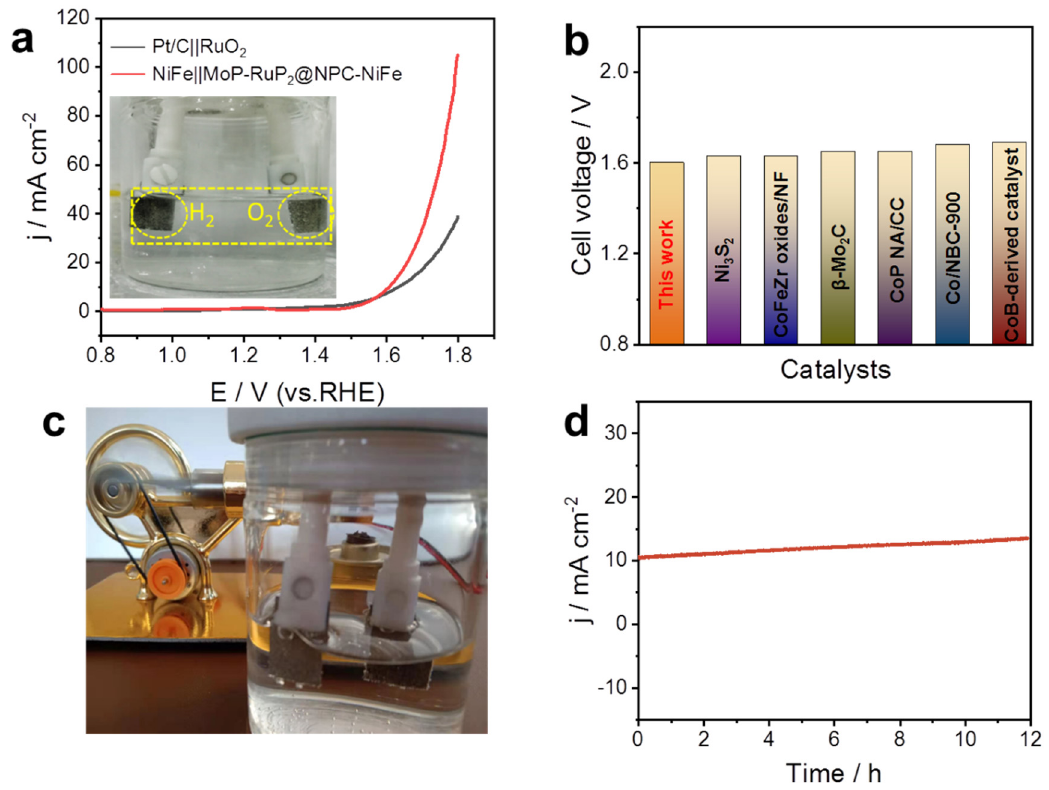
Figure 4. ( a ) Polarization curves of Pt/C||RuO 2 and NiFe||MoP-RuP 2 @NPC-NiFe for overall water splitting in 1 M KOH. ( b ) Comparison of the overpotentials of the synthesized electrocatalysts with the reported values. ( c ) Electrocatalytic process powered using a Stirling engine. Chronoampermetry curve ( d ) of NiFe||MoP-RuP 2 @NPC-NiFe.